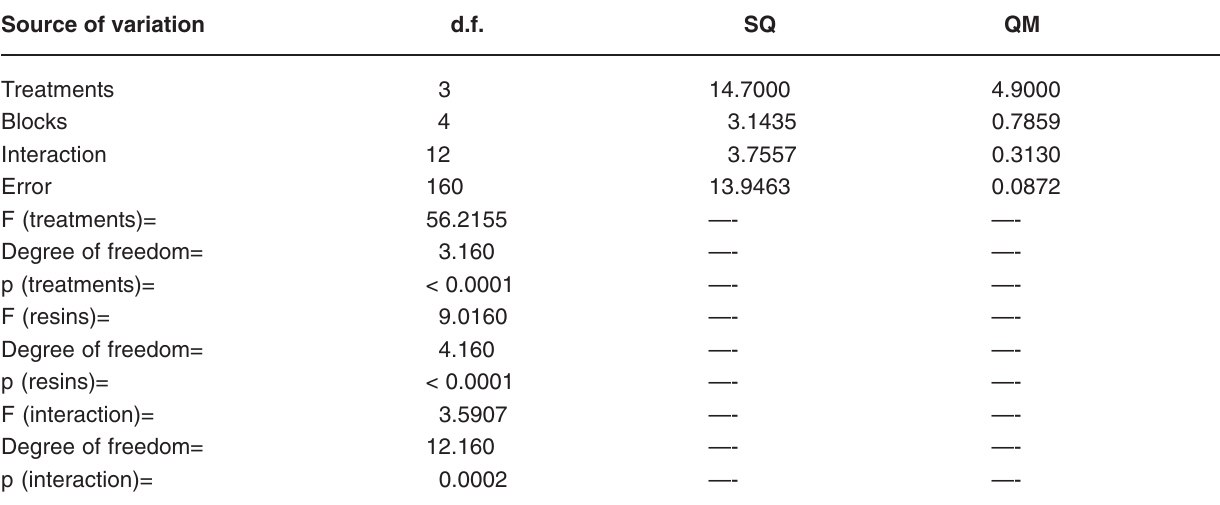
TABLE 4- ANOVA results of the means obtained for the composite resins and polishing